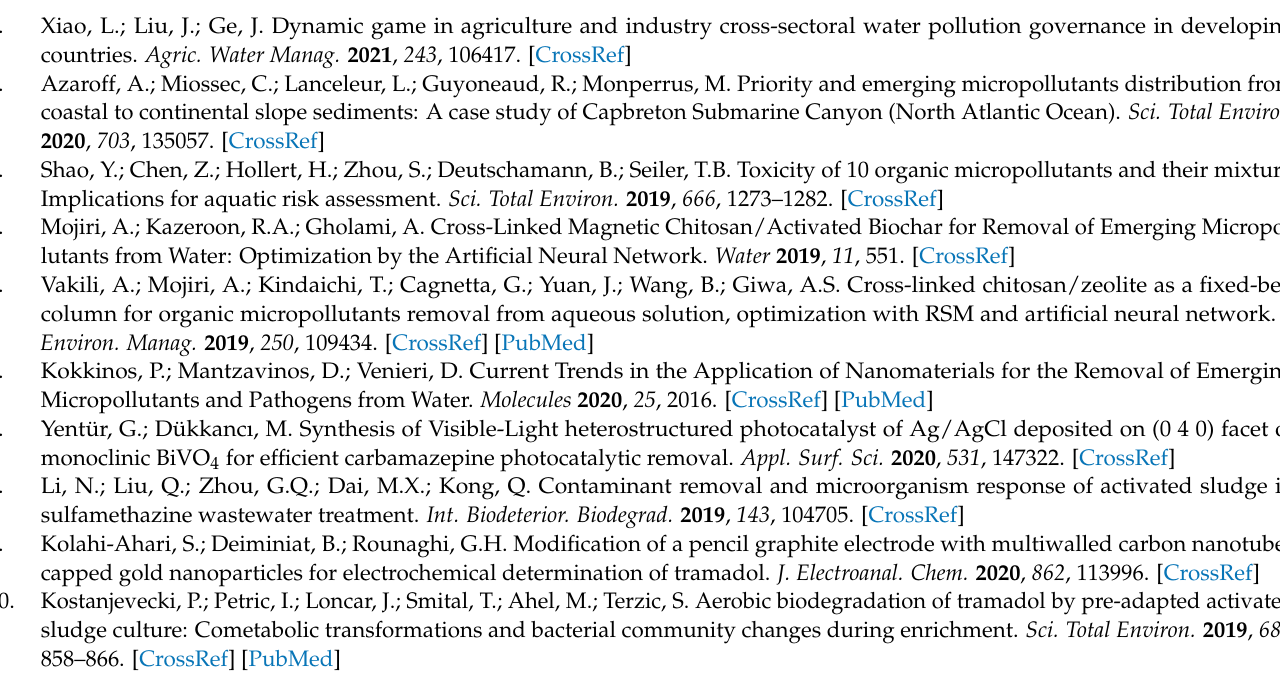
model, Figure S3: Data distribution for removal of CBZ (a), SMT (b) and TRA (c) by the first reactor; RSM model, Figure S4: Data distribution for removal of CBZ (a), SMT (b) and TRA (c) by the second reactor; RSM model, Figure S5: The MSE plots during modeling with ANN for removal of CBZ (a), SMT (b) and TRA (c) by the first reactor, Figure S6: The error histogram during modeling with ANN for removal of CBZ (a), SMT (b) and TRA (c) by the first re-actor, Figure S7: The MSE plots during modeling with ANN for removal of CBZ (a), SMT (b) and TRA (c) by the first reactor, and Figure S8: The error histogram during modeling with ANN for removal of CBZ (a), SMT (b) and TRA (c) by the first